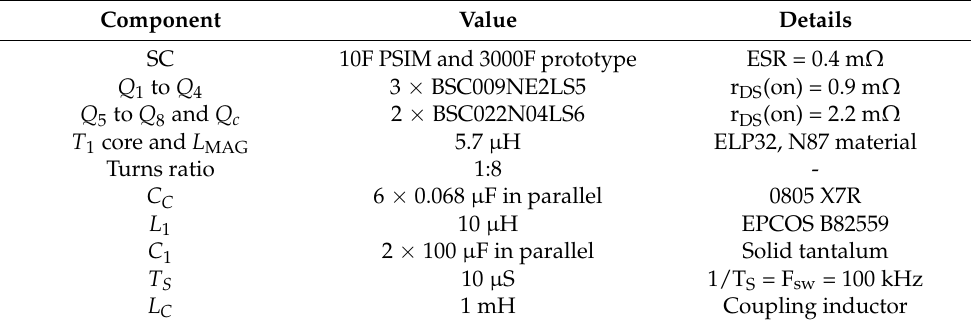
Table 1. Components used for simulation and prototype tests. Component Value Details SC 10F PSIM and 3000F prototype ESR = 0.4 m